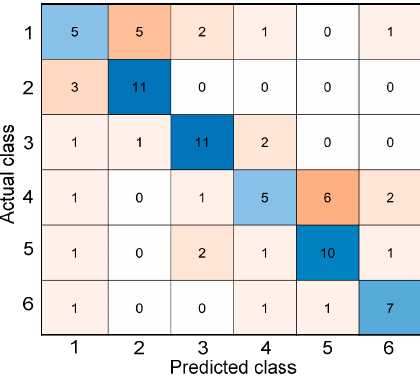
Figure 7. Example of a confusion matrix.